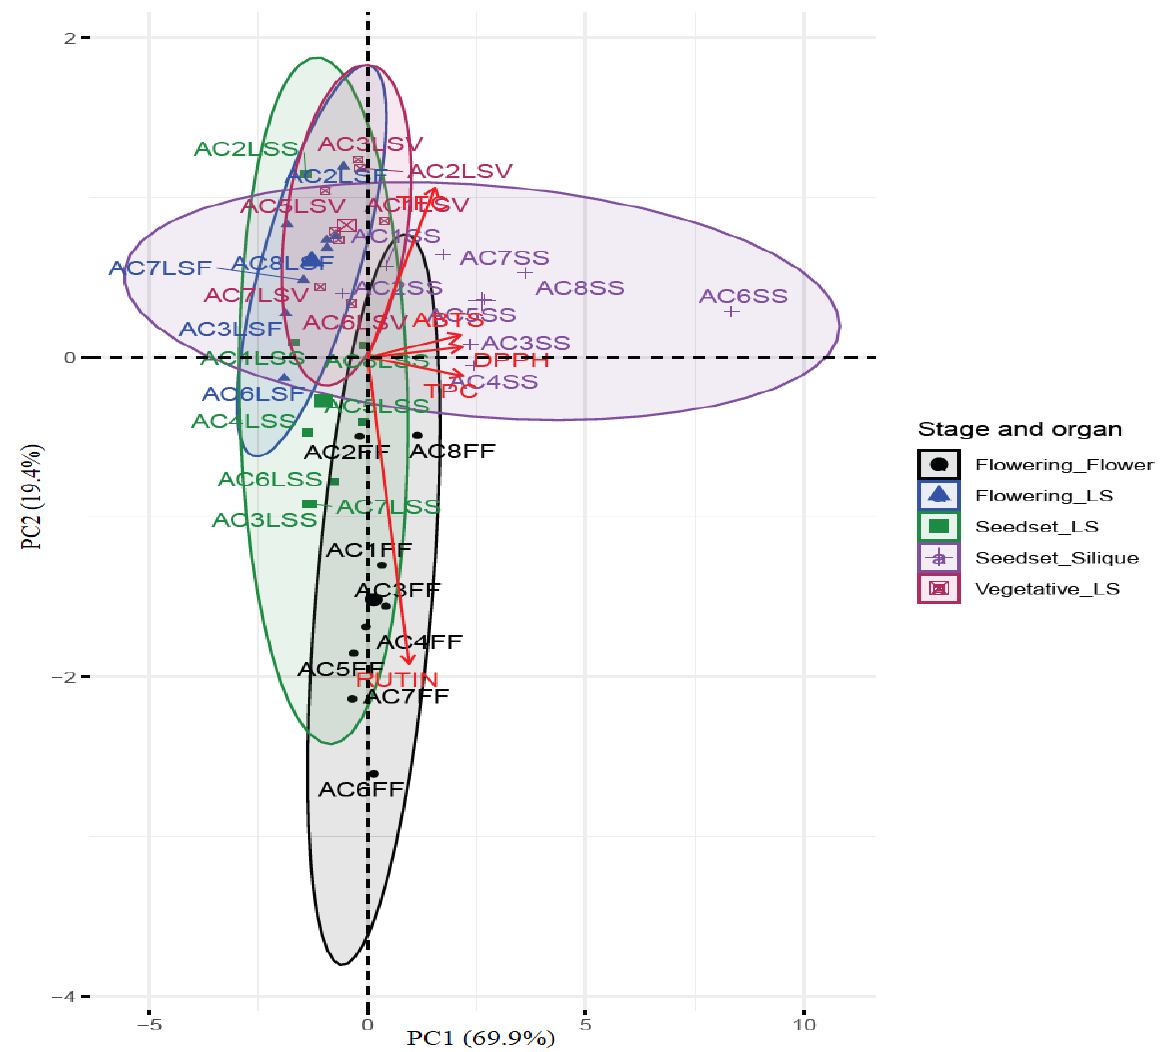
Figure 4. Principal component analysis (PCA) biplot of scores and loadings of the total phenolic, total flavonoid, and rutin content and antioxidant activities of extracts from organs at different growth stages of the eight accessions of CG. AC = accession, TFC = total flavonoid content, TPC = total phenolic content, ABTS = azinobis (3-ehtylbenzothiazoline-6-sulfonic acid), DPPH = 2,2 diphenyl-1-picrylhydrazyl, FF = flower, LSF = leaves and stem at flowering stage, LSS = leaves and stem at seed set stage, LSV = leaves and stem at vegetative stage, SS = siliques at seed set stage. AC1 = TT-00, AC2 = UAG/1907C, AC3 = ELG/1907C, AC4 = ELG/1907B, AC5 = WPK/2007, AC6 = KF-14, AC7 = KF-05A, AC8 = KF-03.